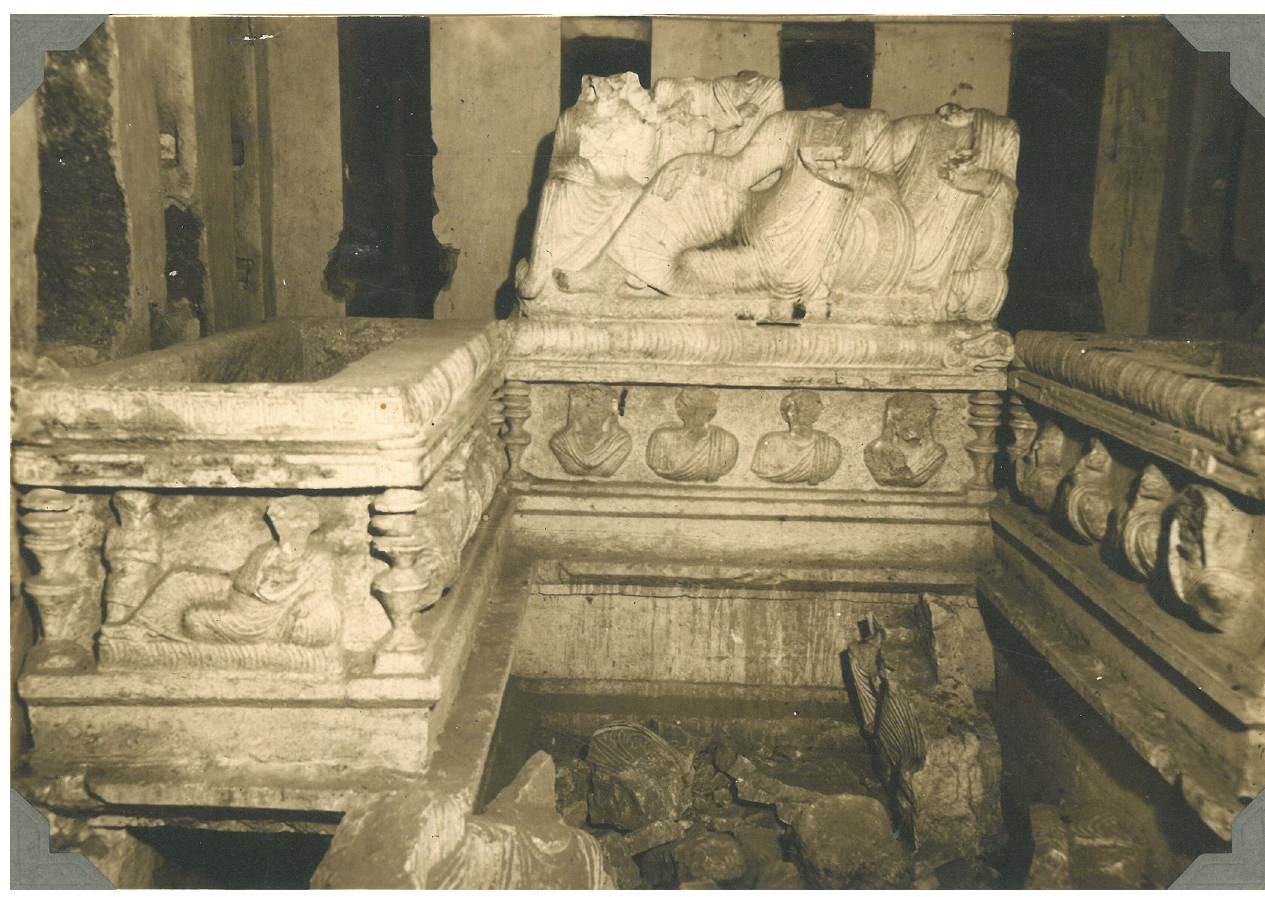
Fig 4. Sarcophagi from the hypogeum of the three brothers. Image © Palmyra Portrait Project, Ingholt Archive at Ny Carlsberg Glyptotek.